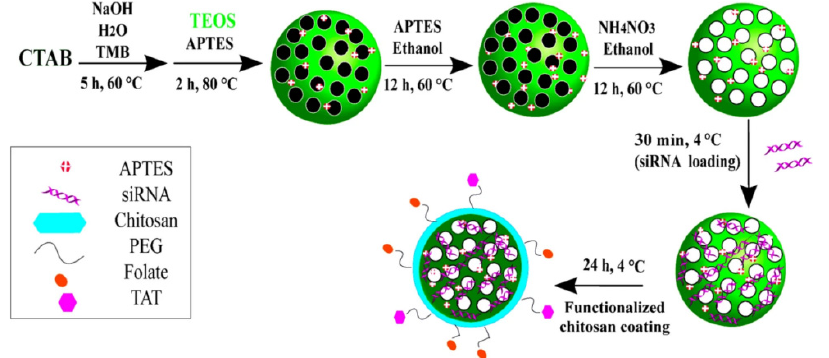
Figure 9. Schematic illustration of synthesis steps and mesoporous silica nanoparticles (MSNs) func- tionalization to obtain NH 2 -MSN, NH 2 -MSN-siRNA, and NH 2 -MSN-siRNA-chitosan functionalized with PEG-folate and PEG-TAT. APTES 3-Amino propyltriethoxysilane, CTAB cetyltrimethylammo- nium bromide, PEG polyethylene glycol, TAT trans-activator of transcription, TMB 1,3,5-triiso- propylbenzene, TEOS tetraethyl orthosilicate. Reprinted with permission from Ref. [211]. 2019, American Chemical Society.